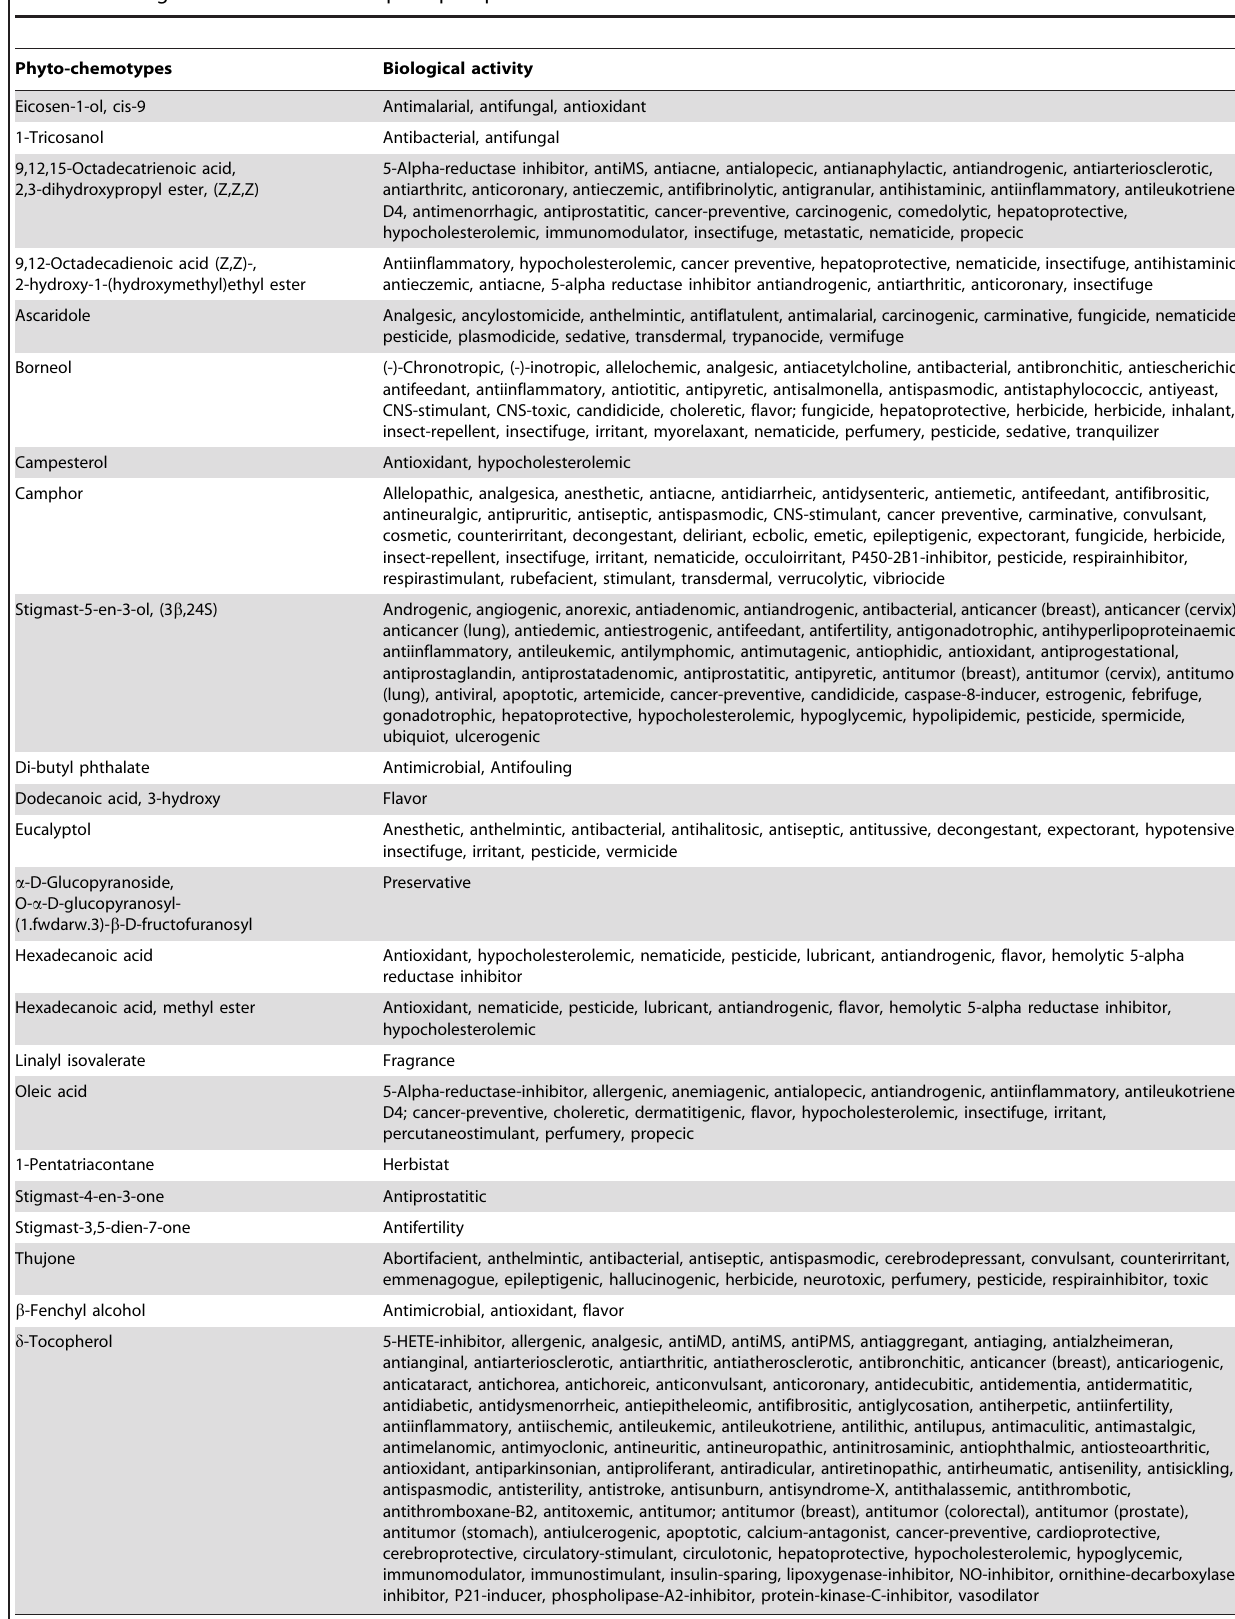
Table 8. Biological activities of active principles present in different root extracts of R. imbricate